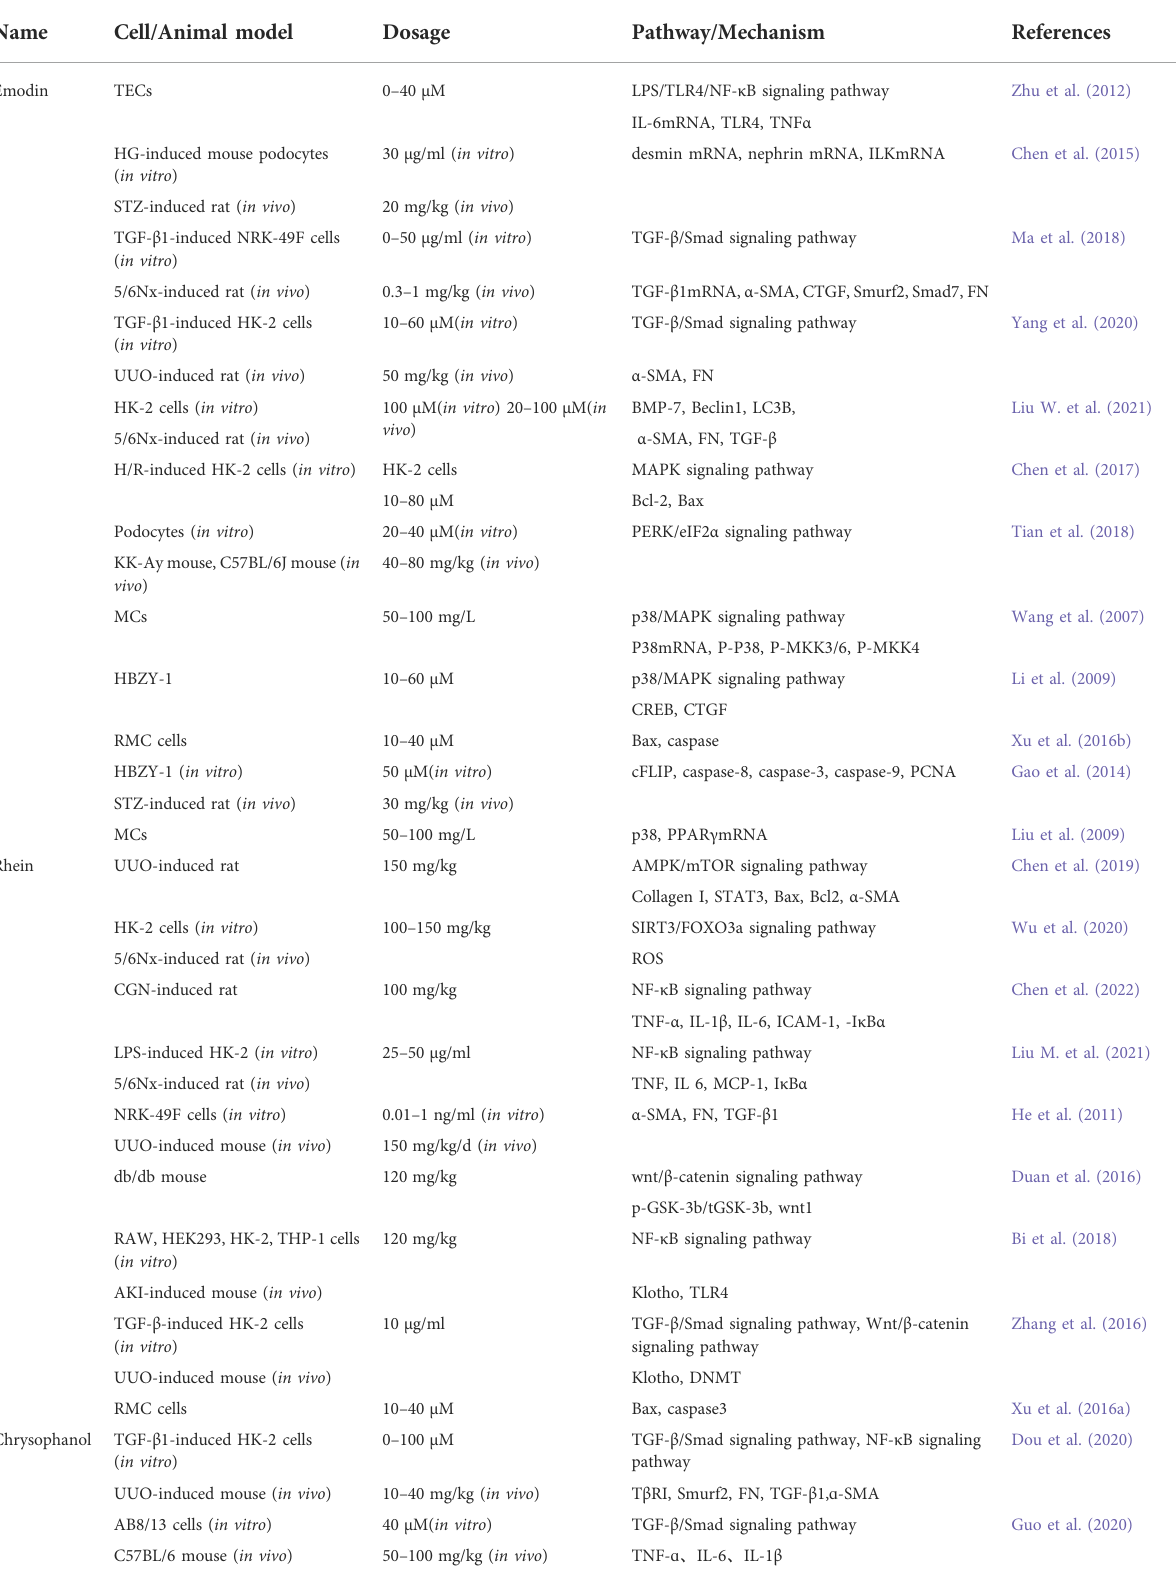
TABLE 1 Mechanism of natural components in rhubarb in the treatment of renal fi